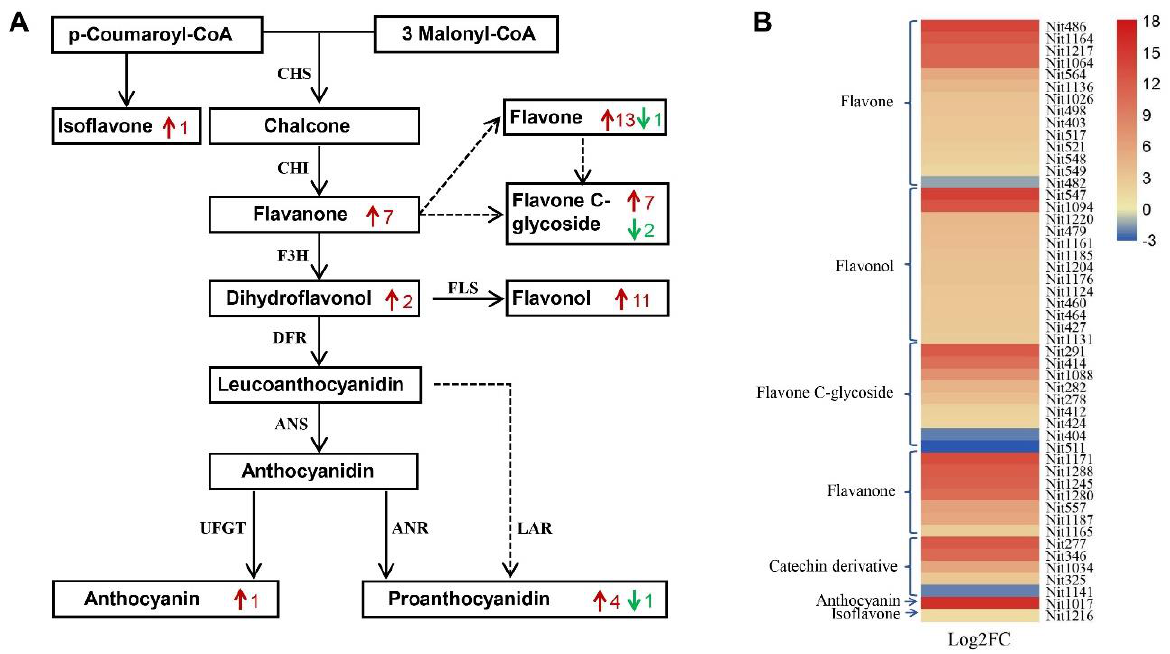
Figure 5. Schematic model and heatmap analysis of metabolites in flavonoid biosynthesis pathways. ( A ) Schematic model of the pathways leading to biosynthesis of anthocyanin, flavonol and PA. ( B ) Heatmap analysis of differential metabolites in flavonoid biosynthesis pathways. The color bar represents the logarithm of metabolite content foldchange (log 2 FC), where the red indicates up-regulated metabolites and the blue indicates down-regulated metabolites.